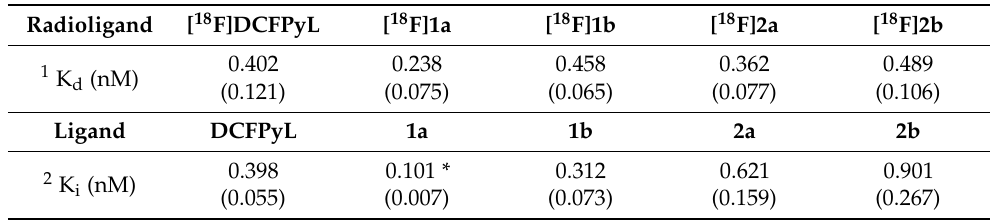
Table 1. Comparison of in vitro parameters of radioligands.